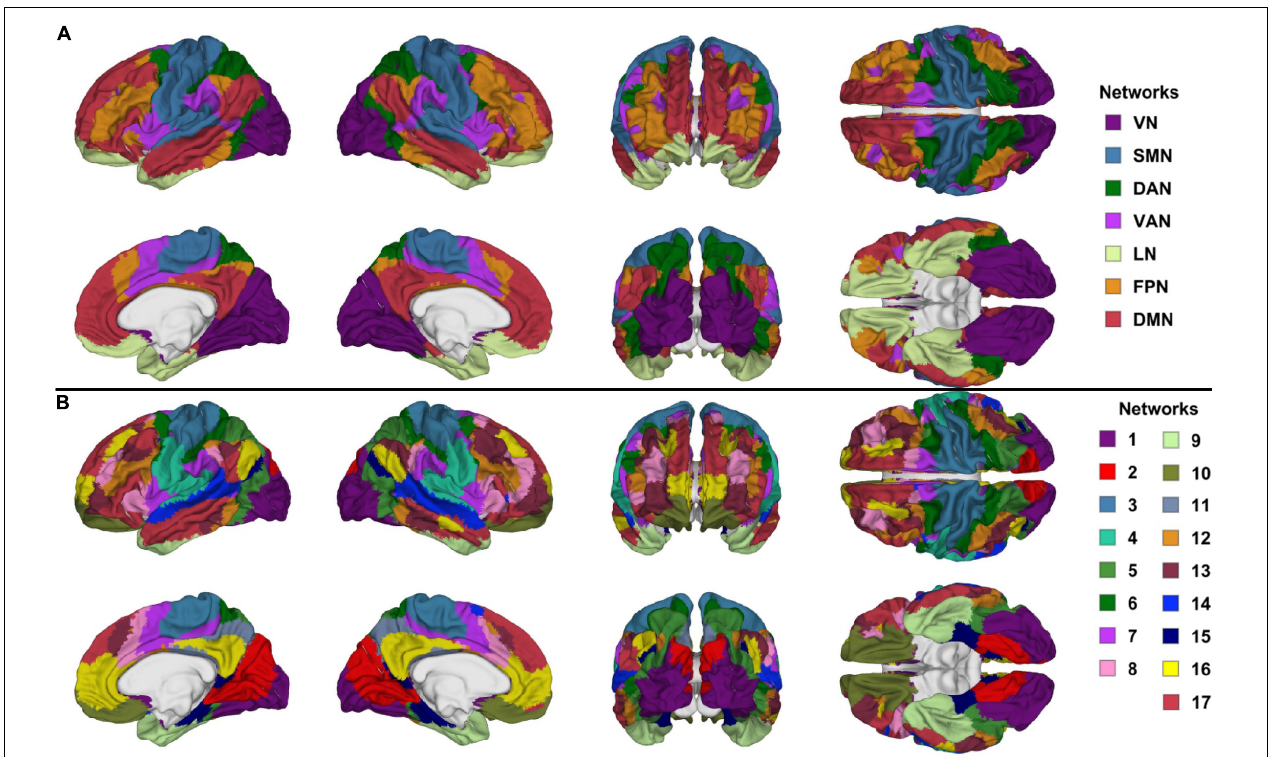
FIGURE 1 | Canonical views (left, right, anterior, posterior, dorsal, ventral, and medial) of (A) the seven canonical RSNs and (B) the 17-network RSNs delineated by Yeo et al. (2011). The color scheme and nomenclature are those used in the original publication (Yeo et al., 2011). RSN, resting state